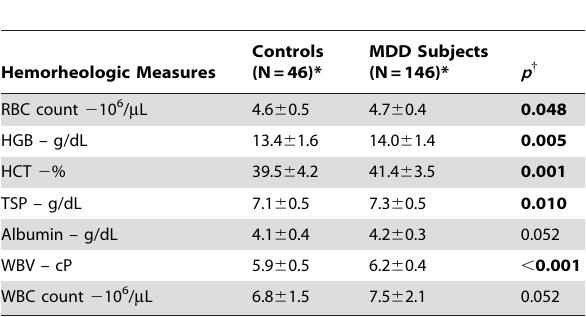
Table 2. Hemorheologic Measures and WBC Count in MDD Subjects before Treatment (week 2 2) and Controls Hemorheologic Measures